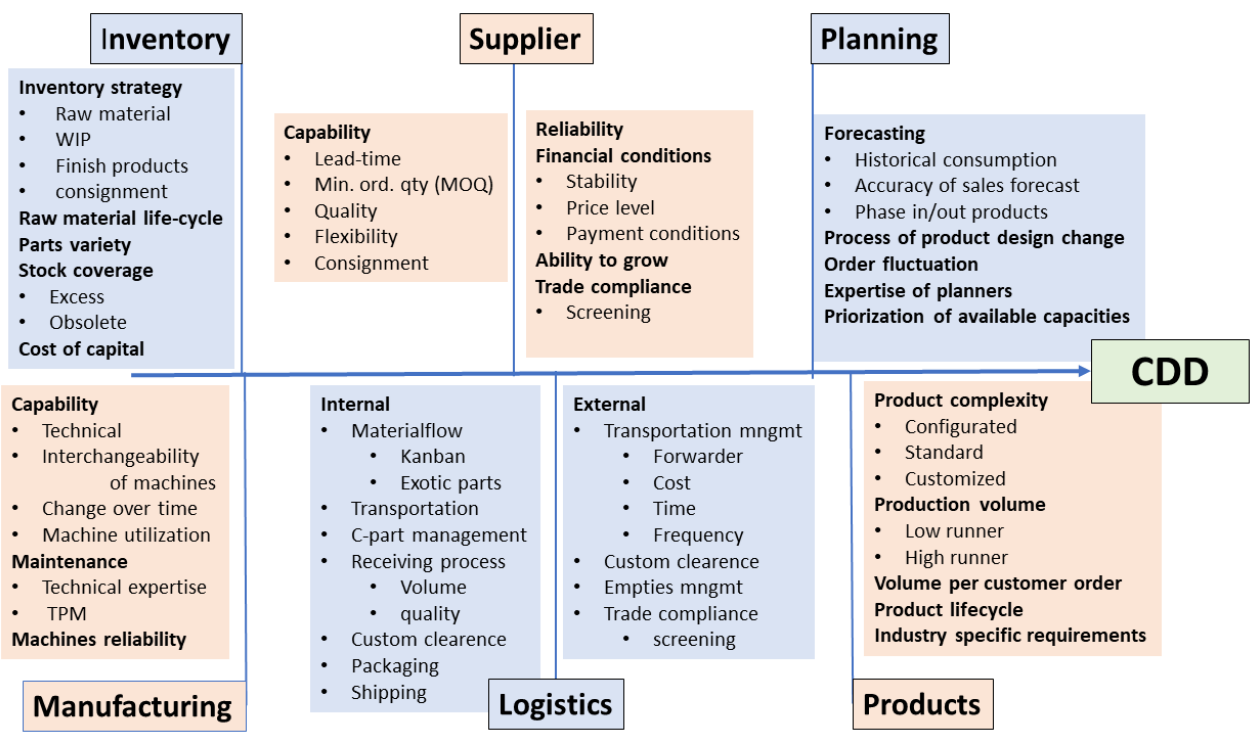
Figure 7. Factors influencing CDD